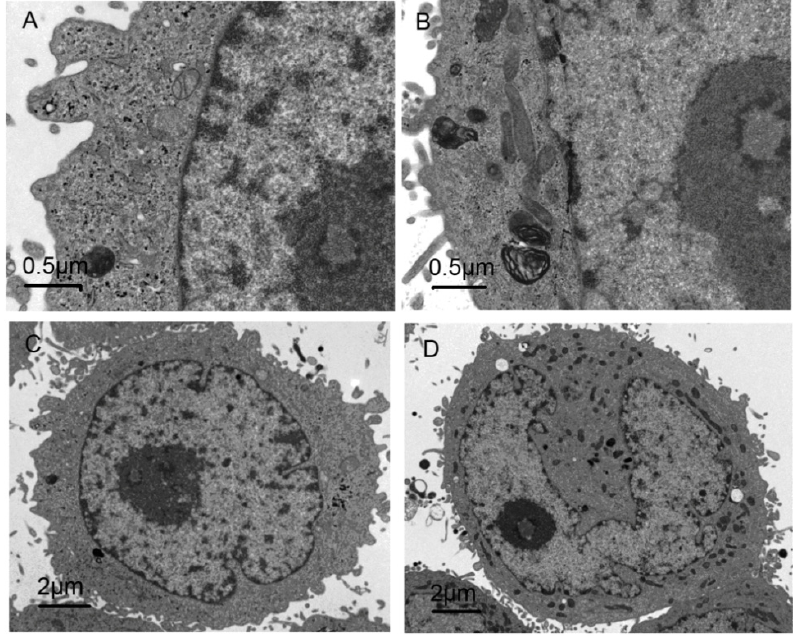
Figure 6. Assessment of cell ultrastructures treated with CPT6 for 48 h using transmission electron microscopy. ( A ) Control group; ( B ) treatment with 0.5 nM CPT6 (cells were observed at ×5000 magnification); ( C ) control group; ( D ) treatment with 0.5 nM CPT6 (cells were observed at ×16,500